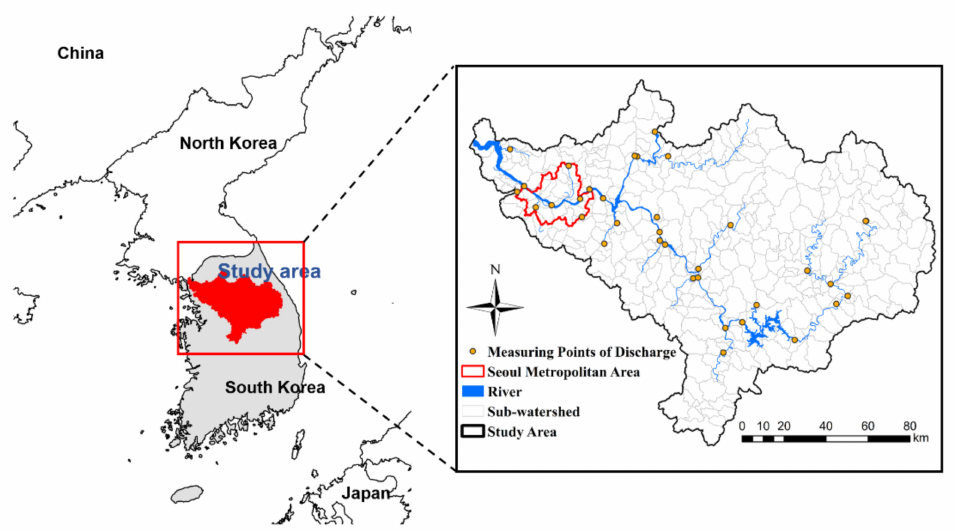
Figure 1. Han River